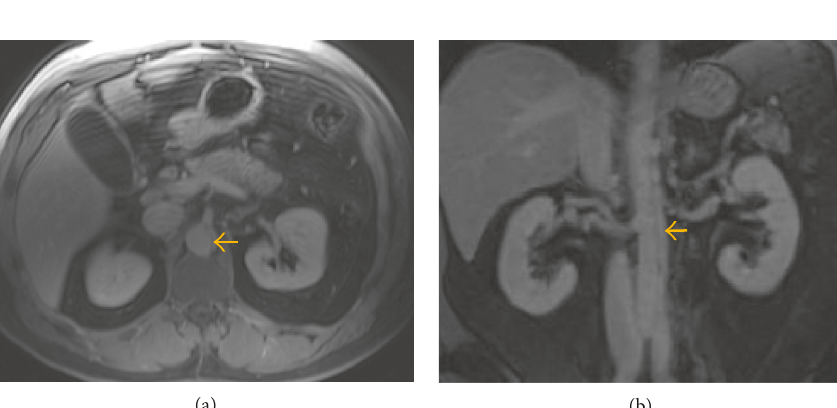
Figure 1: Magnetic resonance cholangiopancreatography (MRCP). (a) Dissection can be seen extending to the origin of the iliac arteries. (b) MRCP demonstrating acute aortic dissection with narrowing of the true lumen (yellow arrow). Of note, there is no peripancreatic inflammatory changes or fluid collections